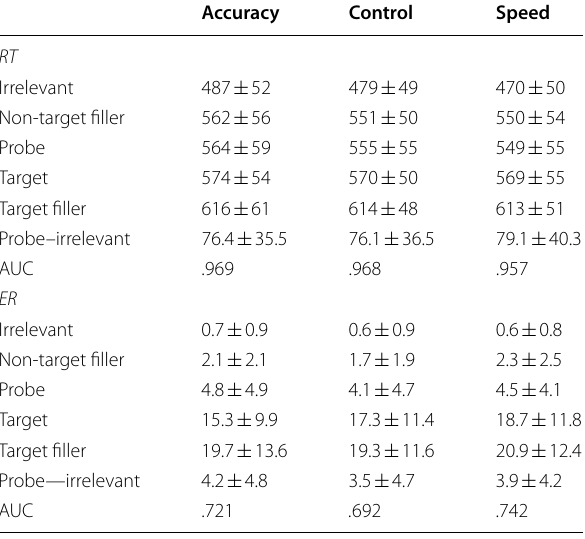
Means and SDs for RT means (in ms, valid trials only) and error rates (in percent), for different item types and per experimental group, as well as areas under the curve (AUC) for RT and ER probe–irrelevant differences as predictor